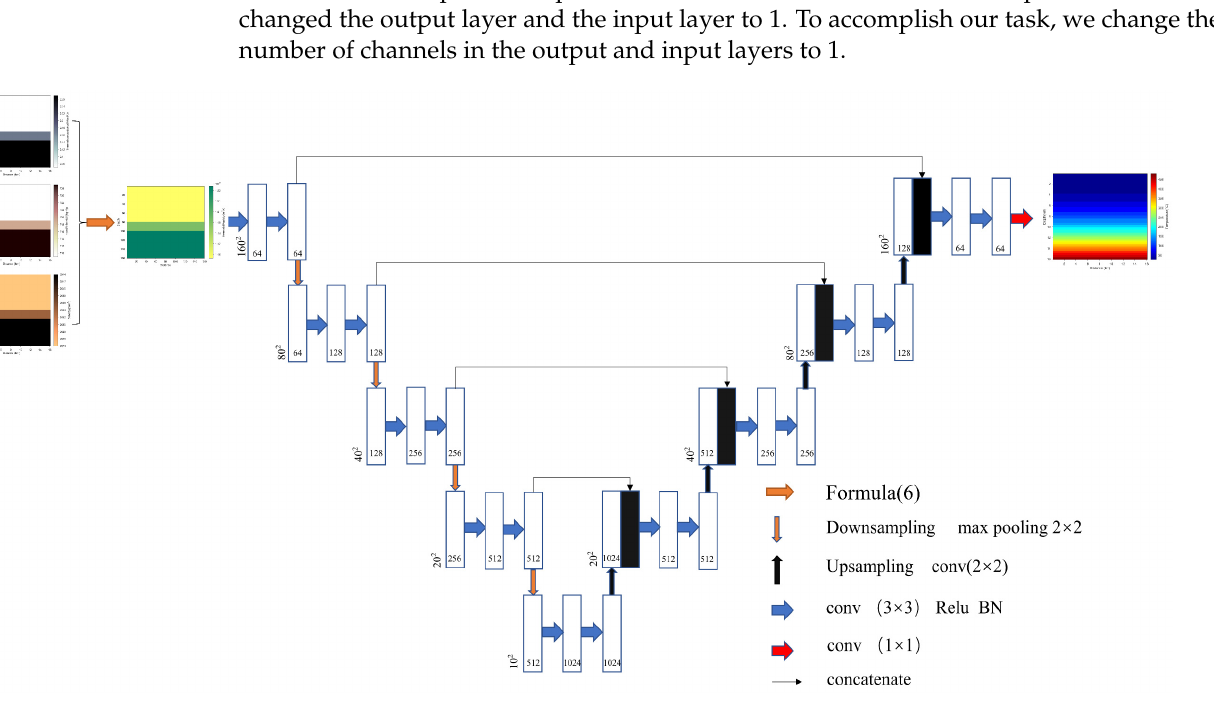
Figure 1. The structure of HDRT − UNet.